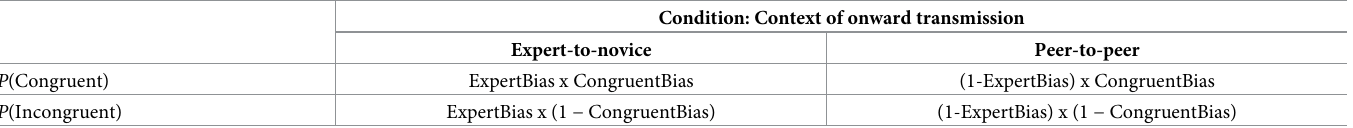
Table 2. Calculation of the probability that the congruent and incongruent variants are produced in each experimental condition as a function of ExpertBias and CongruentBias